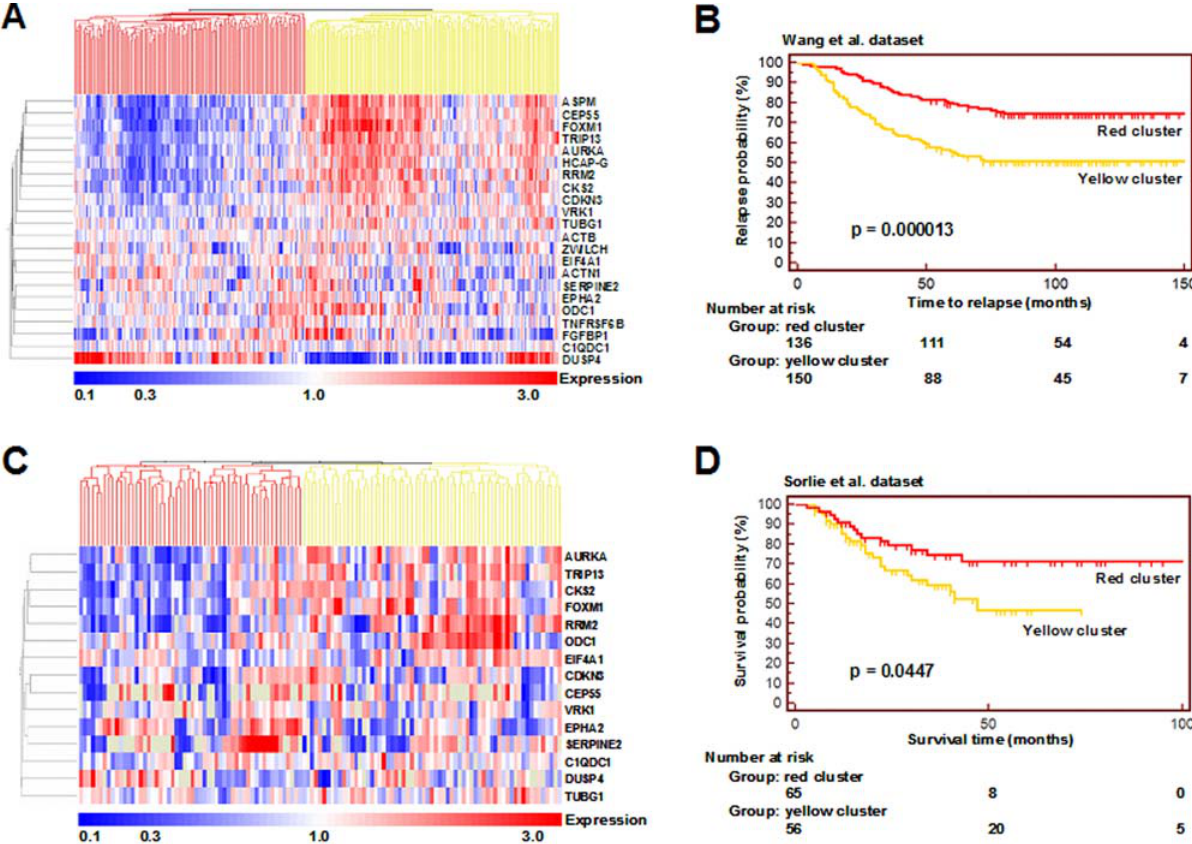
Figure 1. The 22 gene 3D signature predicts survival in the microarray datasets of Wang, etal. , and Sorlie, etal. The 22 gene signature and unsupervised hierarchical clustering grouped breast cancer patients to accurately reflect overall relapse or survival when analyzed by the method of Kaplan and Meier. A. Hierarchical cluster analysis of the dataset of Wang, et al. The pattern of expression of the 22 genes selected by the 3D assay are shown for the 286 breast cancer patients of Wang, et al. Genes and samples were organized by using hierarchical clustering. The two major clusters in the sample dimension (red cluster and yellow cluster), were found by using survival analysis to distinguish between good and poor prognosis patients (p , 0.0001). B. Kaplan-Meier curves for the red and yellow clusters of the hierarchical diagram of panel A. The endpoint recorded for this dataset was relapse, measured in months. C. Hierarchical cluster analysis of Sorlie, et al. dataset. The pattern of expression of the 15 of 22 genes with probes on the Stanford microarrays and with data available for at least 40% of patients are shown for the 121 breast cancer patients reported by Sorlie, et al. Expression was organized by hierarchical clustering. The two major clusters in the sample dimension (red cluster and yellow cluster), were found by using survival analysis to distinguish between good and poor prognosis patients (p=0.00447). D. Kaplan-Meier curves for the red and yellow clusters of the hierarchical diagram of panel C. The endpoint recorded for this dataset was death, measured in months.